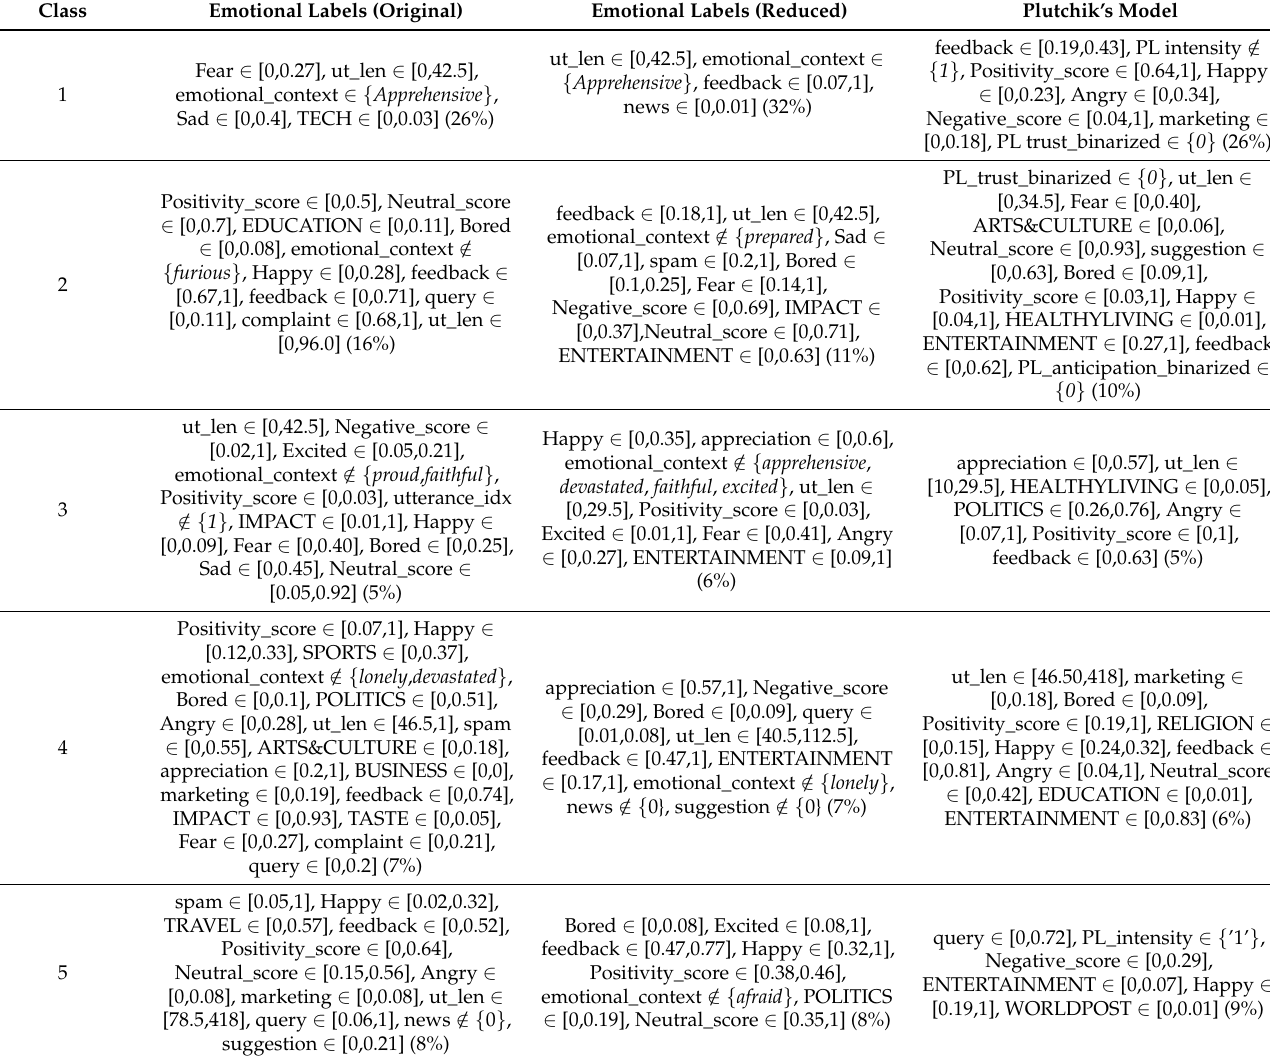
Table 11. Most significant patterns found for each class by an Emotional context